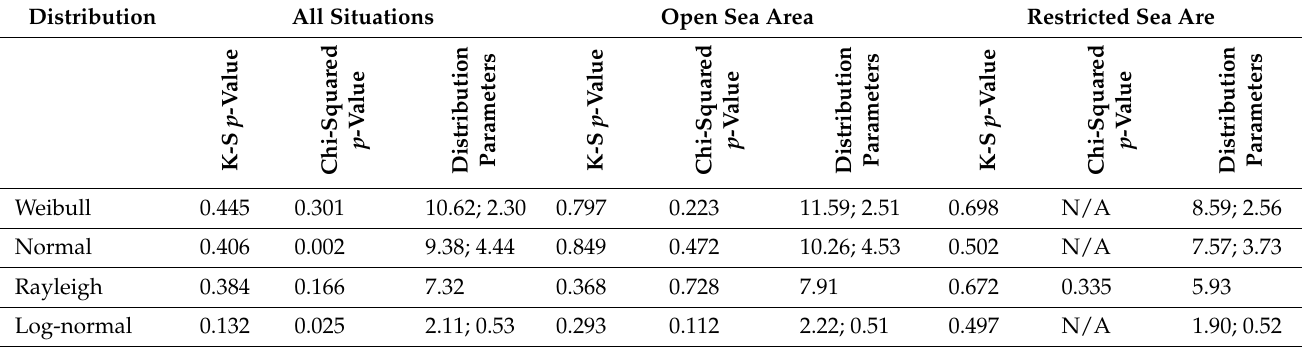
Table 3. p -values and distributions parameters calculated for the distance between ships at the start of the anti- collision